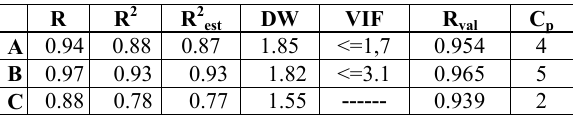
Table1. The statistical parameters